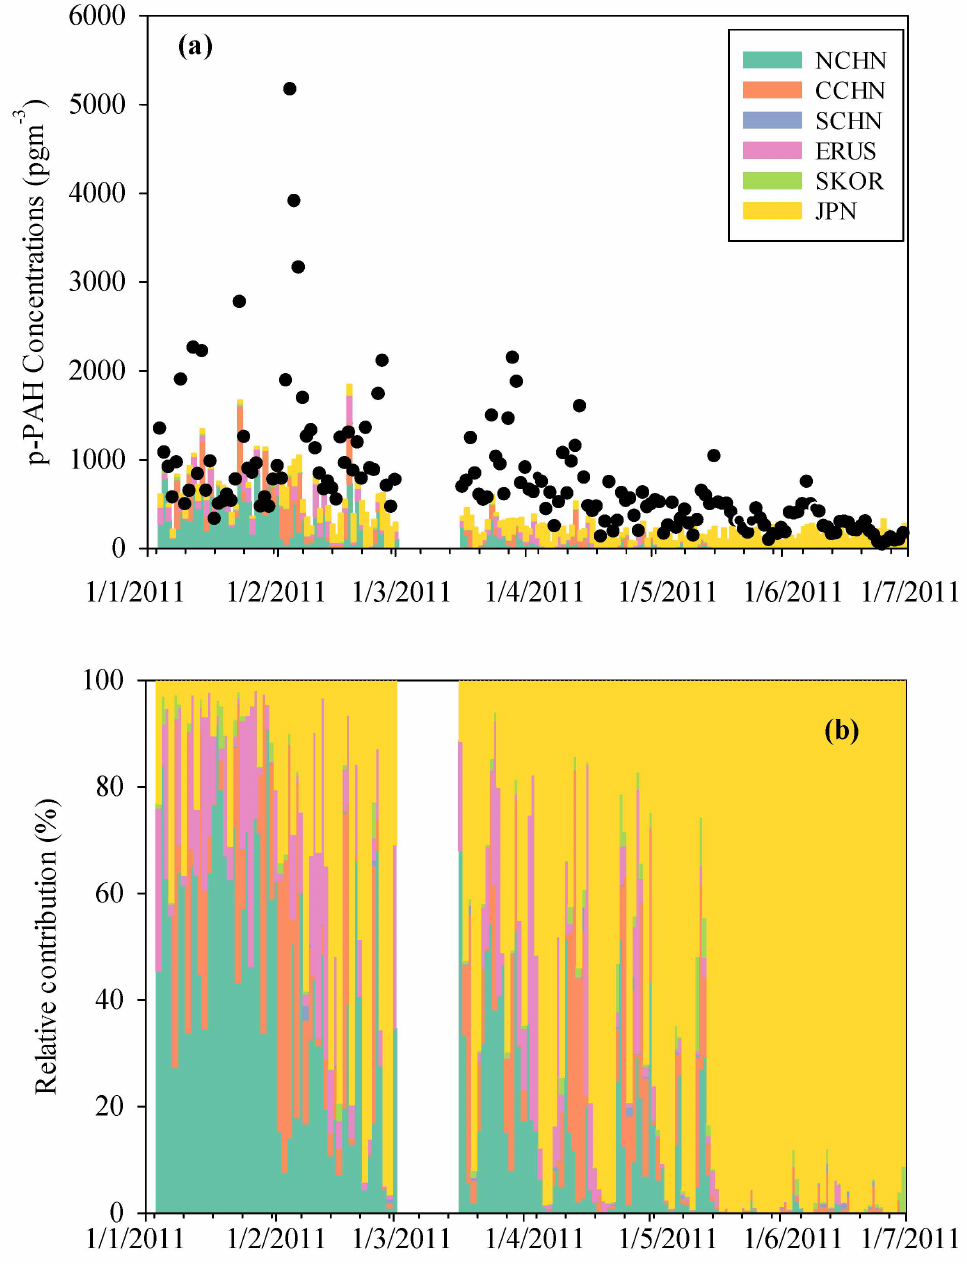
Figure 4. Temporal variations in the p-PAH concentration in Kanazawa from 1 January to 30 June 2011. ( a ) Simulated and observed concentrations, ( b ) relative contributions of the six source